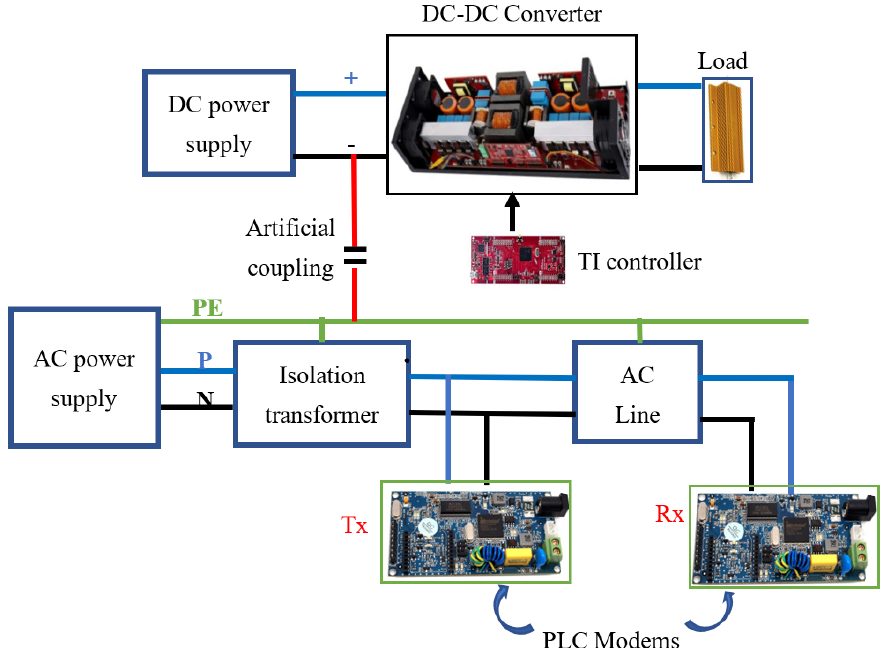
Figure 3. Schematics of the experimental test bench with the G3-PLC system coupled to the DC-DC converter through a coupling capacitor.